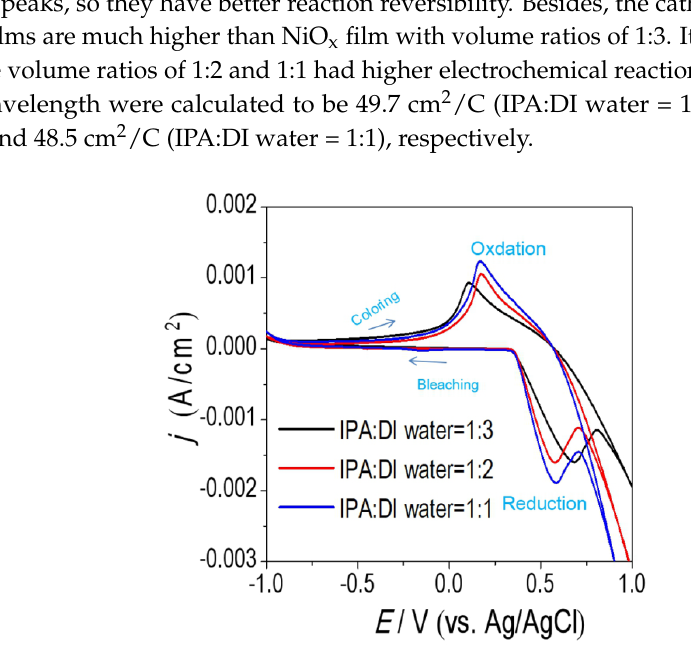
Figure 10. CVs of the NiO x films in different volume ratios of IPA:DI water in NiO x inks in 1 M KOH electrolyte. The NiO x films are spin-coated three times and annealed to 150 ◦